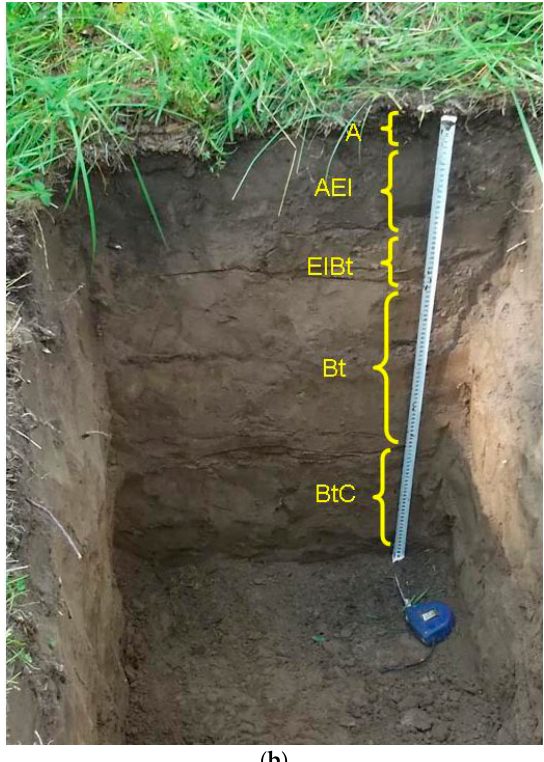
Figure 1. The general view of the mature undisturbed birch forest in the forest-steppe in the south of West Siberia ( a ) and the profile of the Gley-Luvic Phaeozem under it ( b ). Letters denote soil genetic horizons.